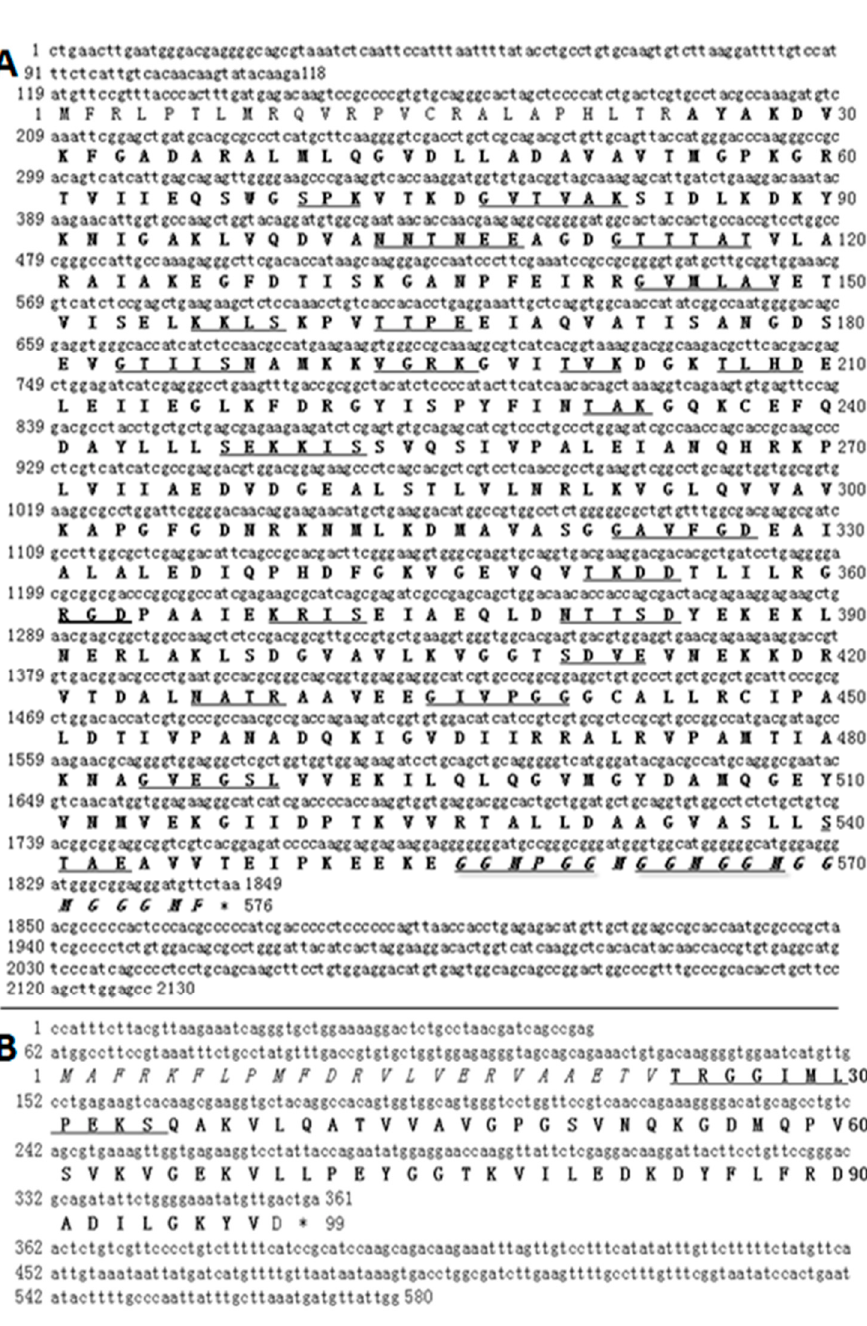
Gly-Gly-Met (GGM) repeat is in italic. ( B ) is shown the Cn-HSP10: The putative mitochondrial targeting sequence is in italic. The conserved domain (GroES domain) is shaded in bold; the predicted mobile loop is underlined.